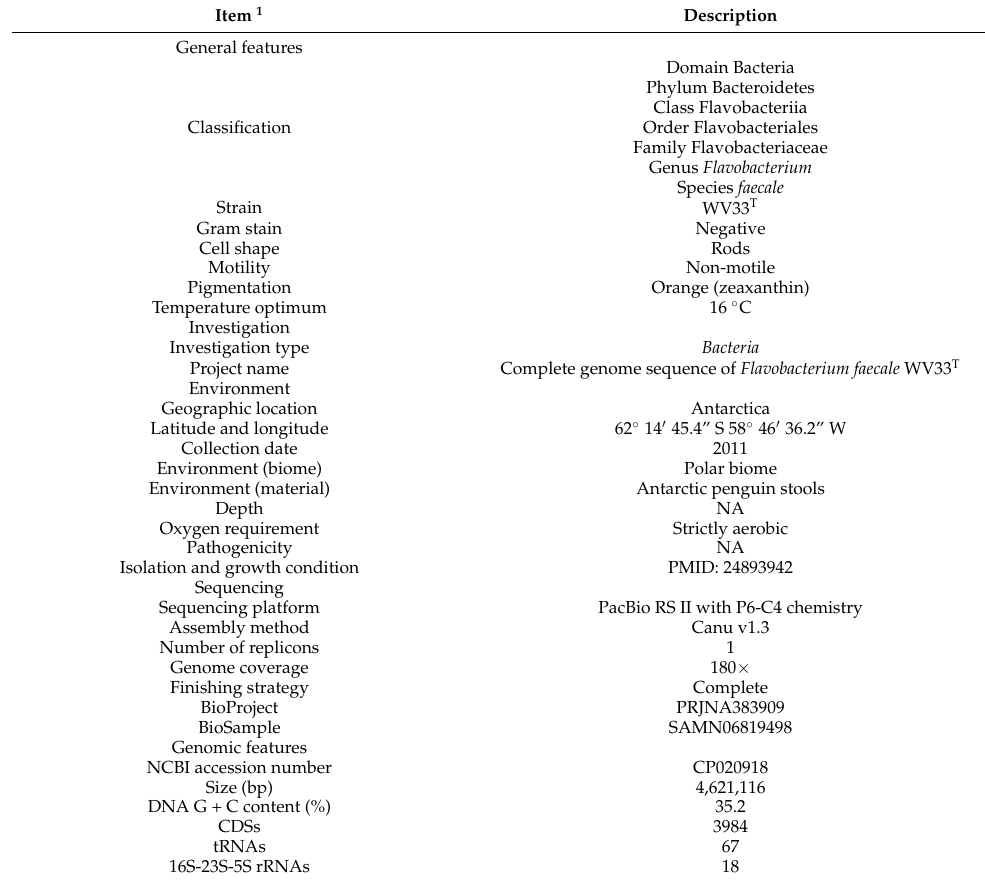
Table 1. General features and genome sequencing information of F. faecale WV33 T according to the minimum information about a genome sequence (MIGS) mandatory information.